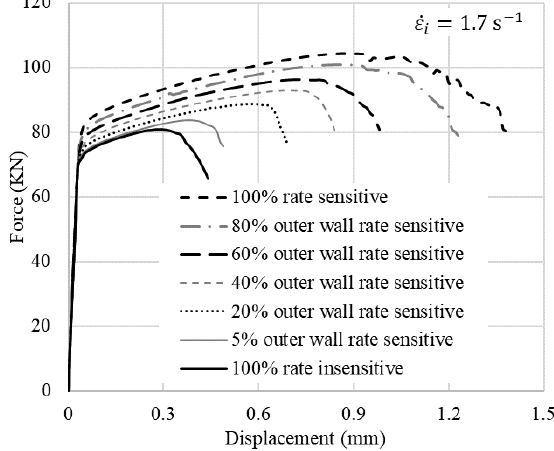
Figure 11. Effect of different volume fractions on the f–d curves.